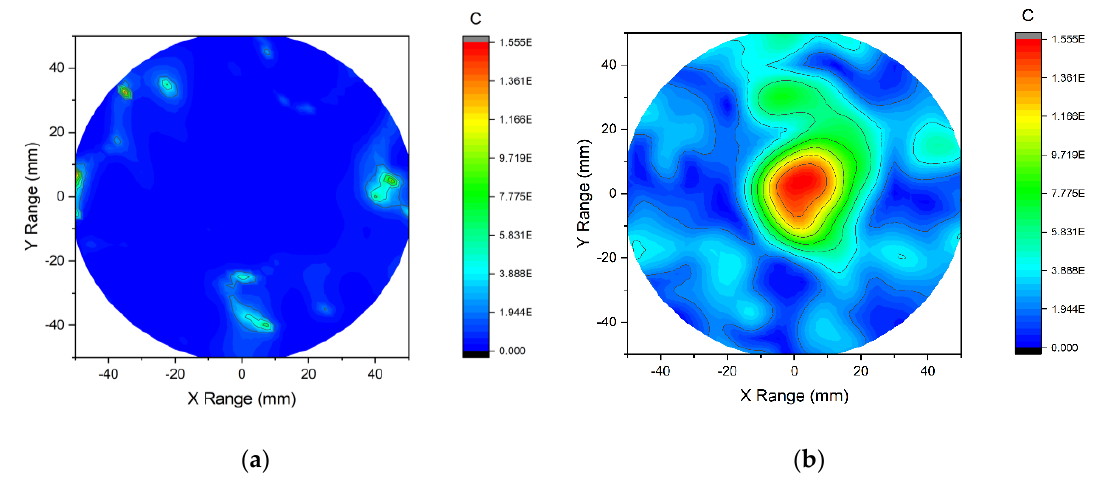
Figure 14. Reconstructed Images of the breast phantom: ( a ) Phantom without tumor; ( b ) Phantom with tumor. Table 4. Performance comparison outcomes among the reported antennas and the proposed antenna. Ref.